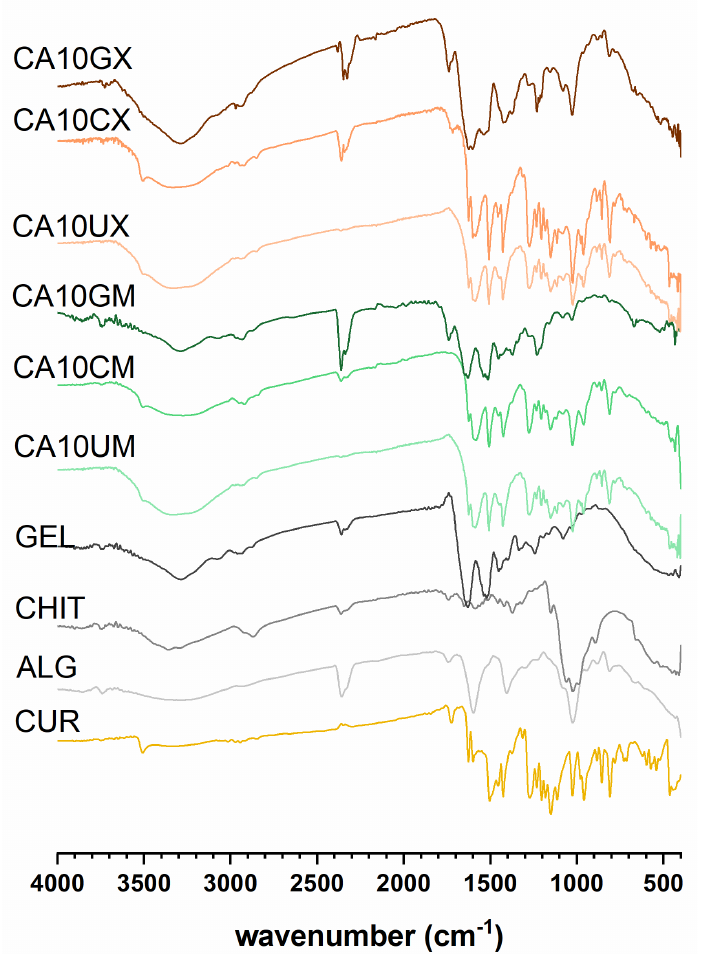
Figure 1. Fourier transform infrared spectroscopy (FTIR) results for curcumin (CUR), sodium alginate (ALG), chitosan (CHIT), gelatin (GEL), and CUR-loaded micro- (CA10UM, CA10CM, CA10GM) and macroparticles (CA10UX, CA10CX, CA10GX) (see Table 1 for details of the particle composition).